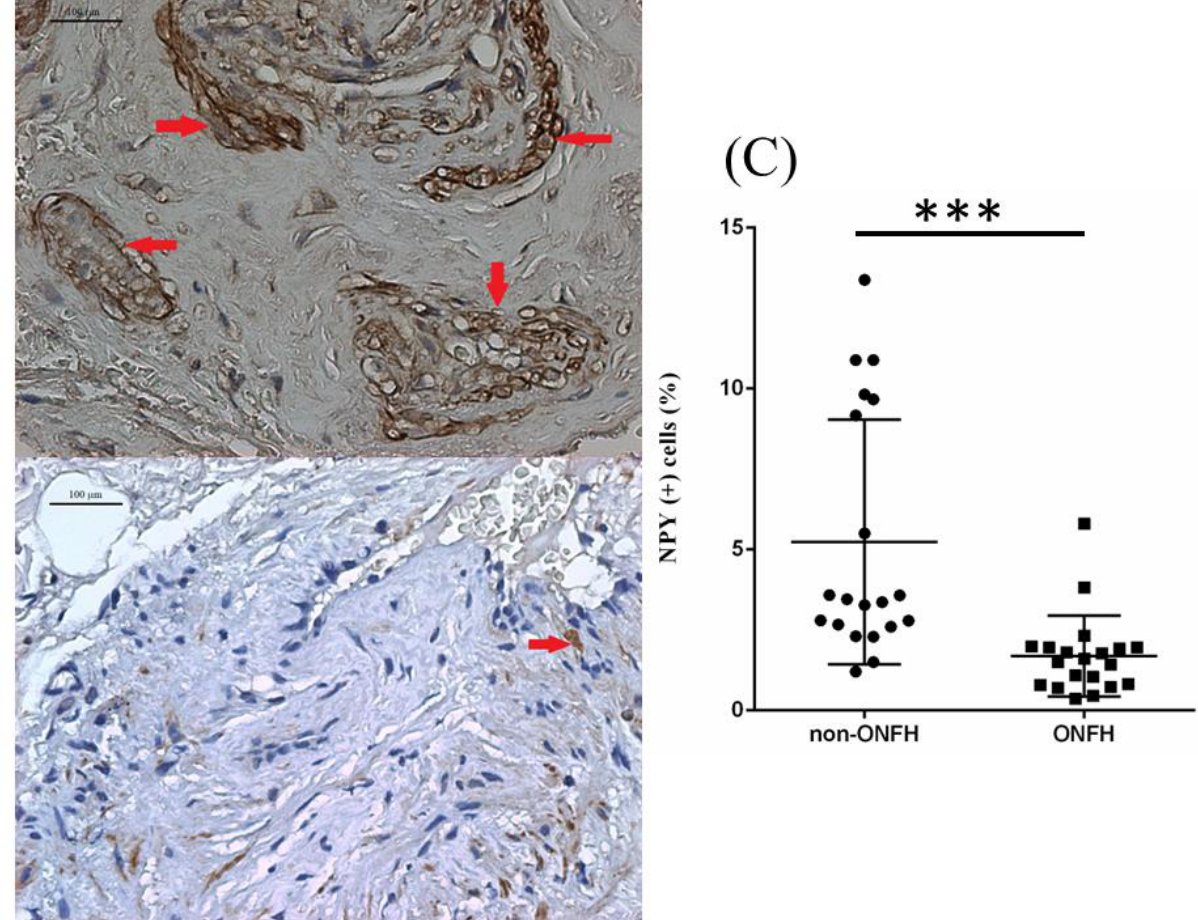
Figure 1. The representative illustration of NPY IHC staining of the femoral head obtained from non-ONFH ( A ) and ONFH ( B ) patients, and the percentage of NPY positively stained cells between non-ONFH and ONFH groups ( C ) (*** p < 0.001). The red arrows indicate positively stained cells. The black dots and the black squares indicate the information concerning the percentage of NPY (+) cells for respective patients.